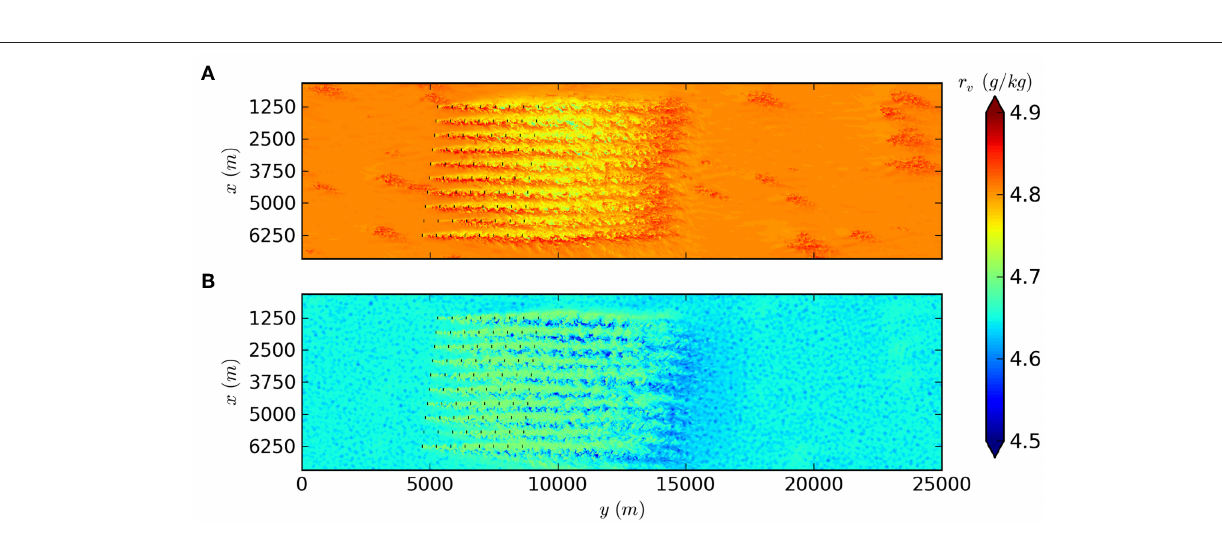
FIGURE 9 | Horizontal cross-sections at 30 m (A) and 110 m (B) above the sea of the vapor mixing ratio r v . The black plain lines (–) indicate the locations of wind